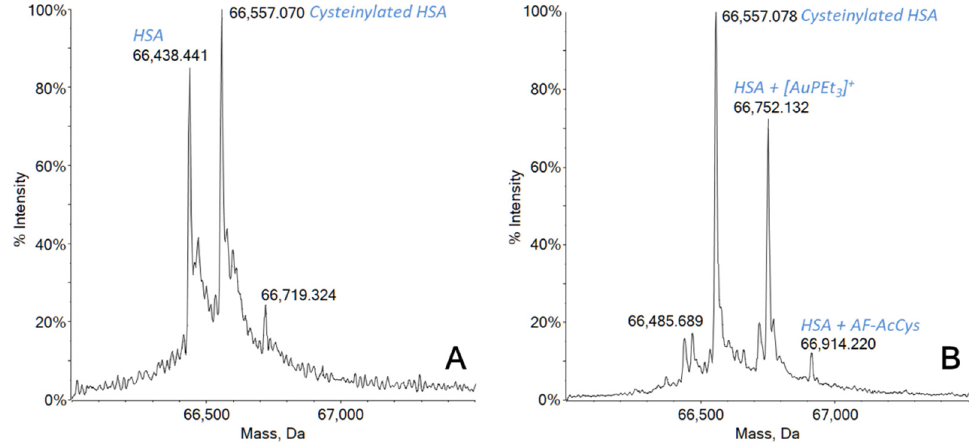
Figure 2. Deconvoluted ESI mass spectra of ( A ) HSA 5 × 10 − 6 M in 20 mM ammonium acetate solution, pH = 6.8, and ( B ) HSA 5 × 10 − 6 M incubated with AF-AcCys (1:2 ratio) for 2 h at 37 ◦ C in 20 mM ammonium acetate solution, pH = 6.8.